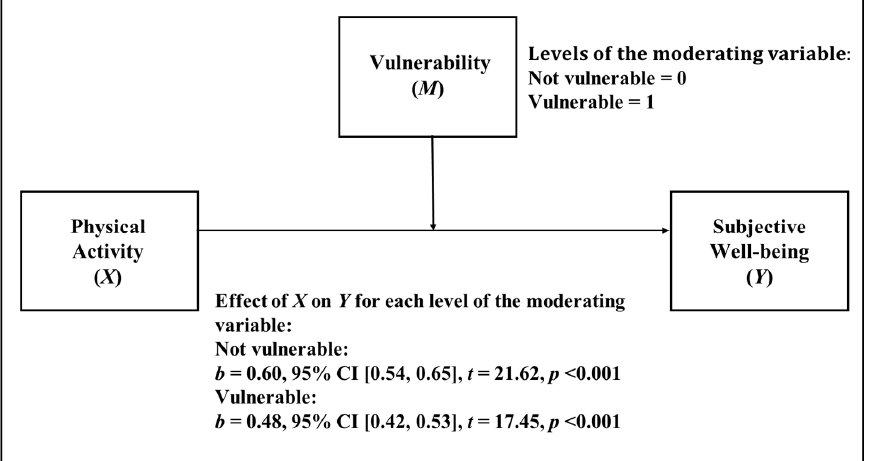
Figure 3. Simple moderation model in which socioeconomic vulnerability is considered as modera- tor.